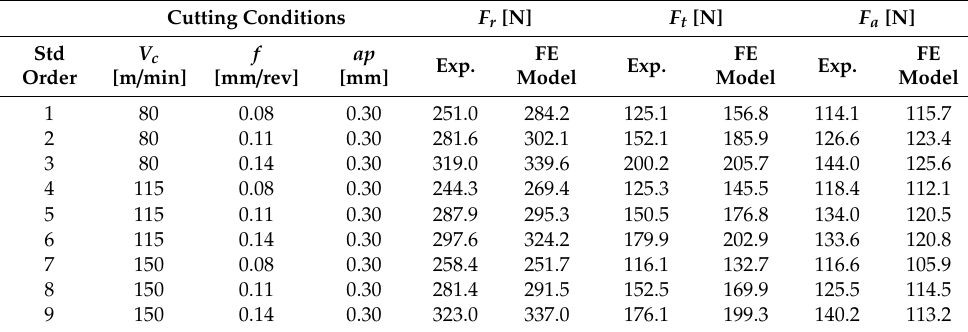
Table 3. Comparison between experimental and numerical values for the machining